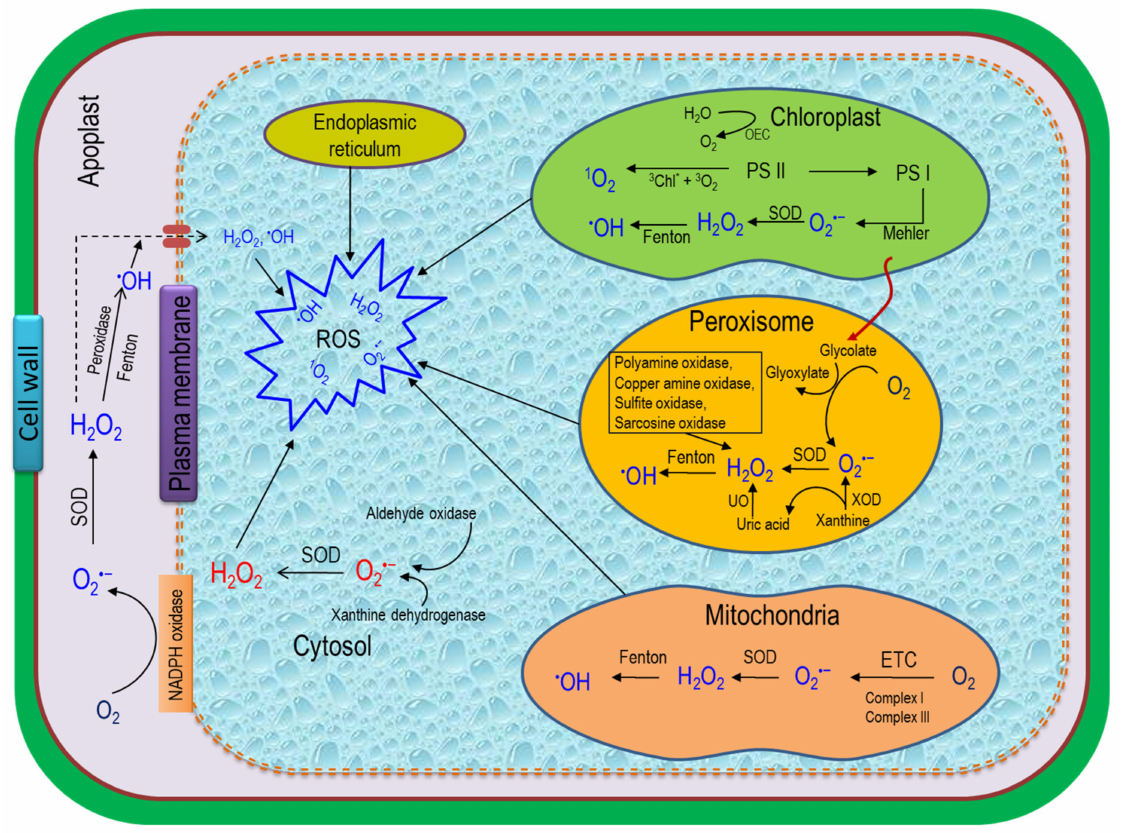
Figure 3. ROS generation process and localization in plant cells. In different cell organelles, ROS are produced through metabolic reactions where different enzymatic and non-enzymatic pathways are involved. ROS—reactive oxygen species; H 2 O 2 —hydrogen peroxide; 1 O 2 —singlet oxygen; ETC—electron transport chain; • OH—hydroxyl radical; 3 Chl*—triplet chlorophyll; PS I—photosystem I; PS II—photosystem II; O 2 •− —superoxide anion; XOD—xanthine oxidase; SOD— superoxide dismutase; NADPH—nicotinamide adenine dinucleotide phosphate; UO—urate oxidase